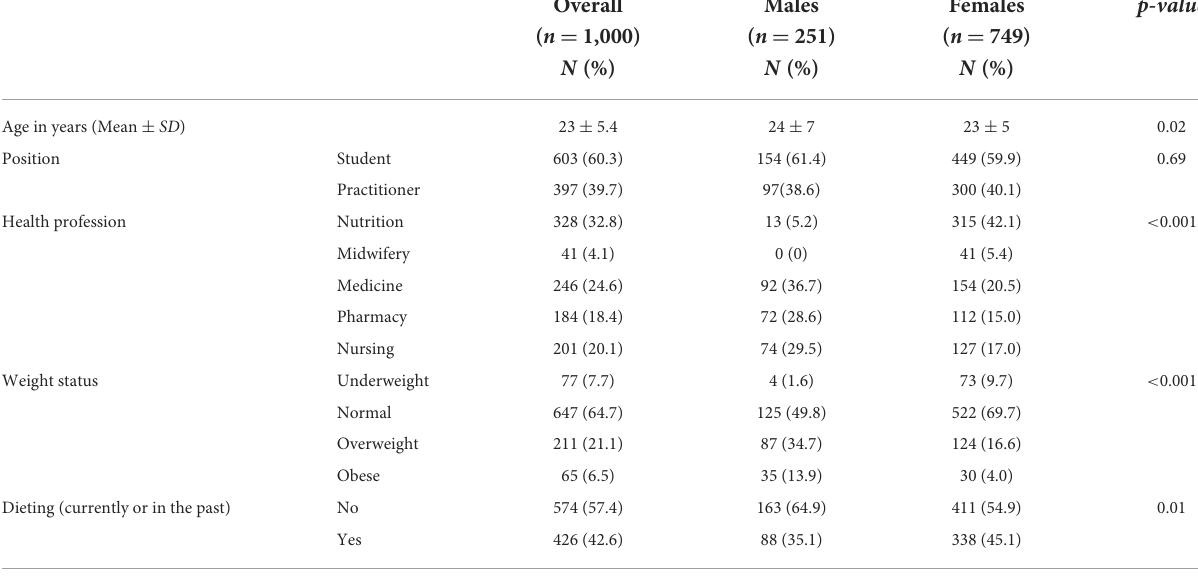
TABLE 1 Demographic characteristics and weight status of study participants.